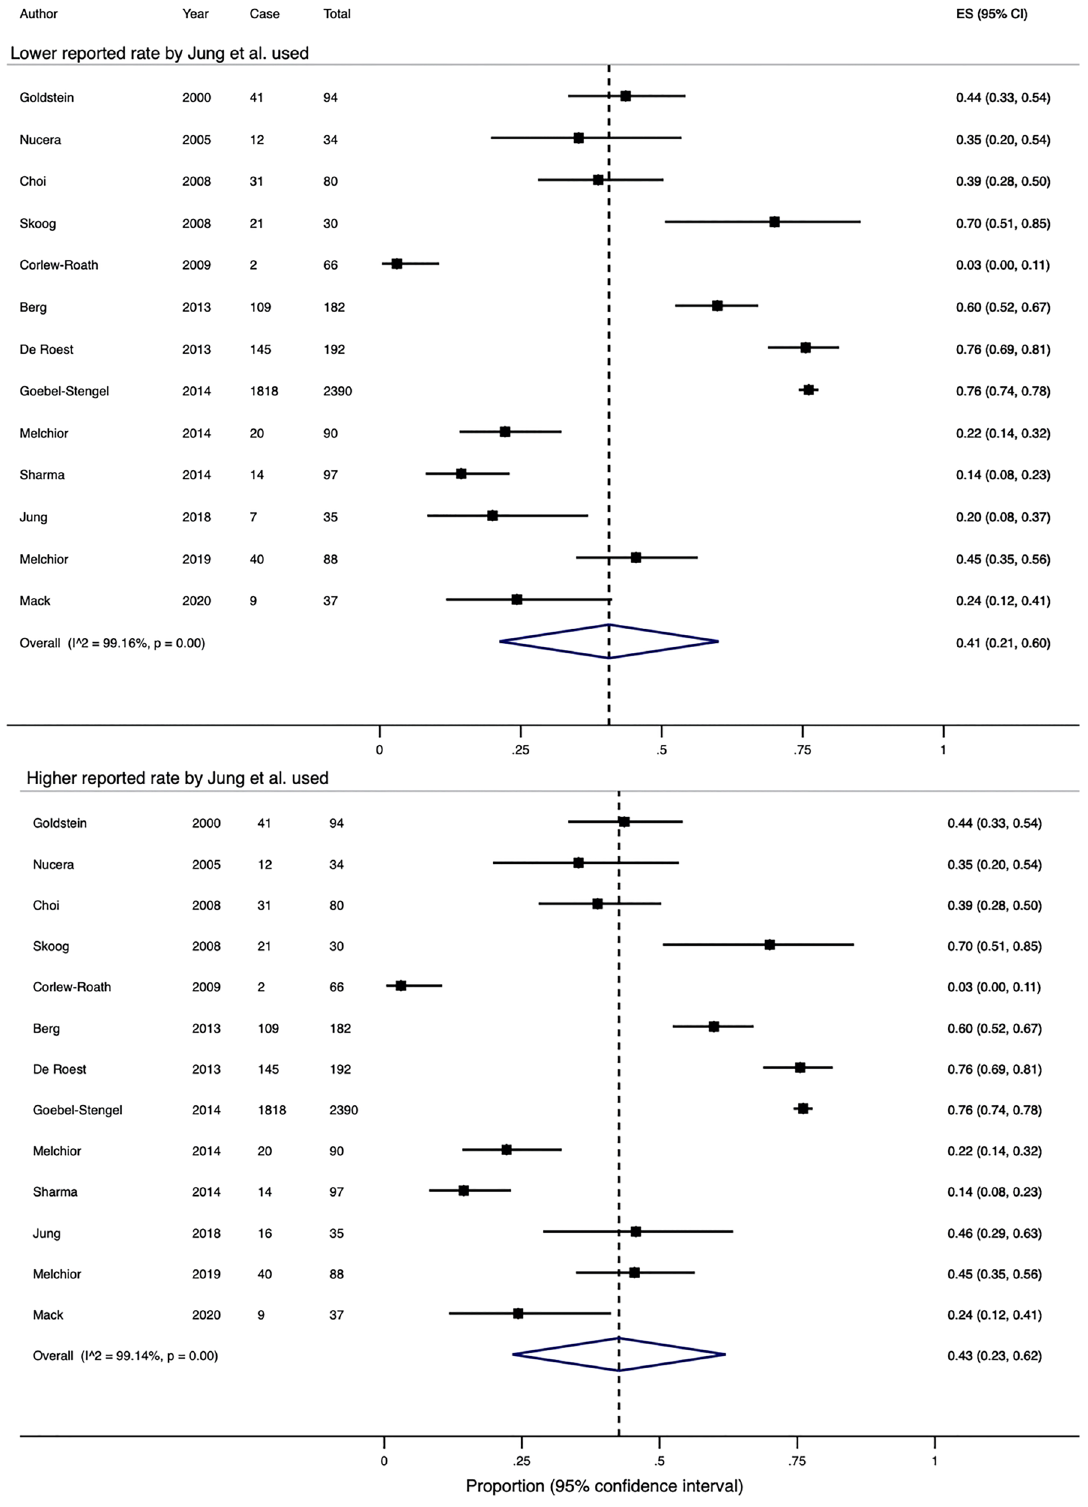
Figure 3. Forest plots showing the estimated pooled prevalence of fructose malabsorption using breath